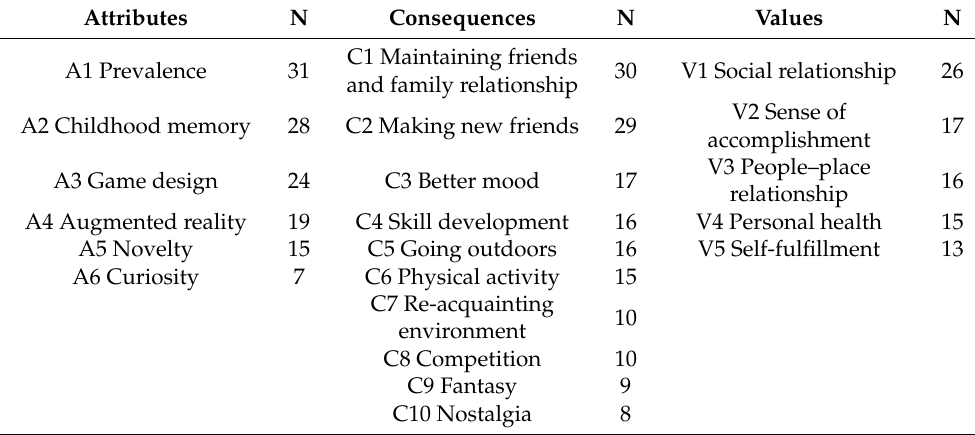
Table 2. Attributes, consequences, and values of Pok é mon Go users’